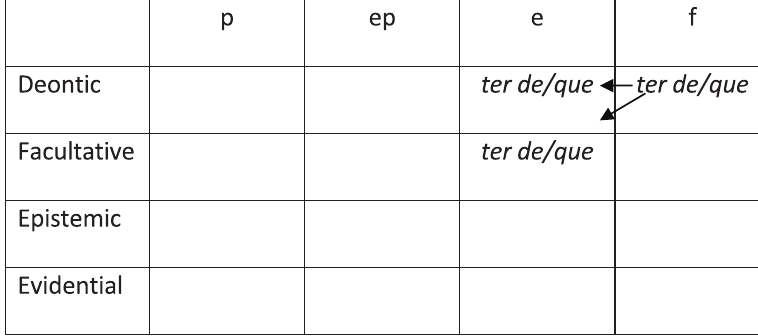
Figure 4: Hypothesized development of ter